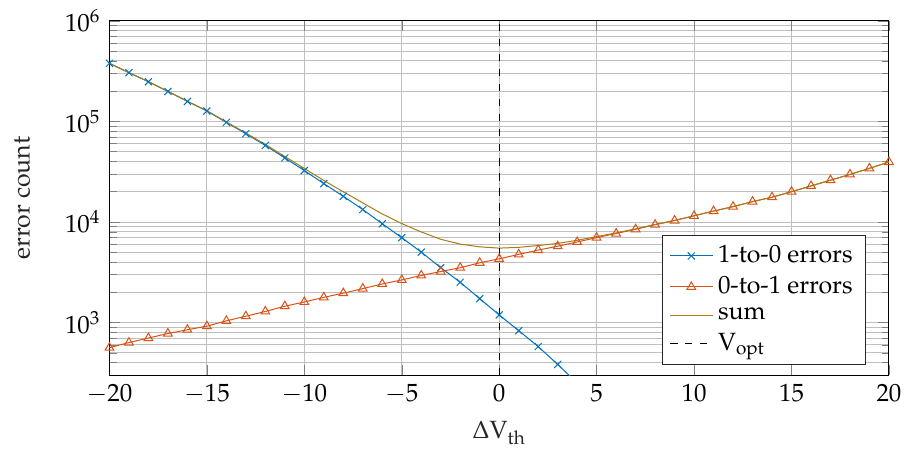
Figure 5. Error count for 1-to-0 errors and 0-to-1 errors versus the threshold voltage for r 7 of fresh flash memory.